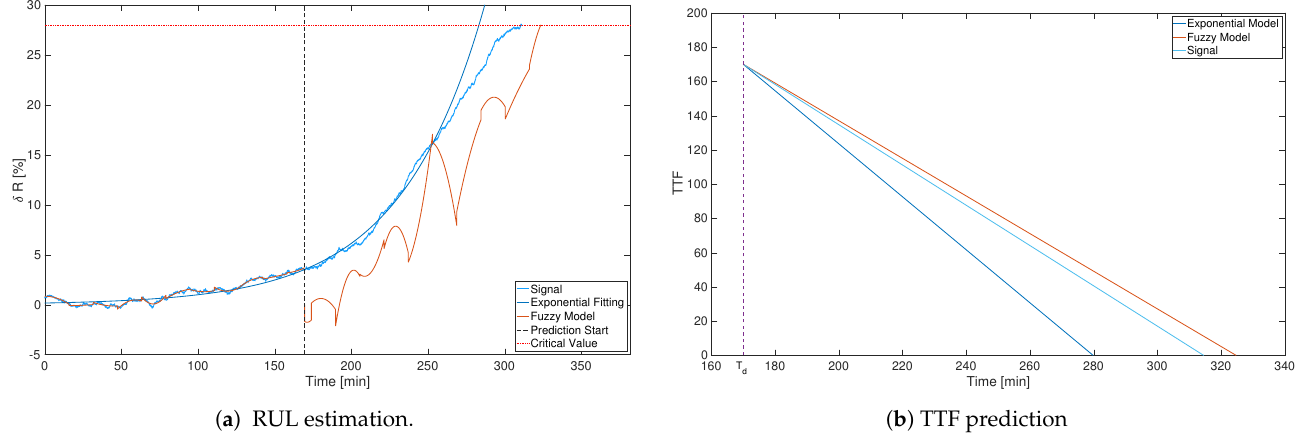
Figure 16. RUL and TTF analysis of the 36th MOSFET after 55% of its real